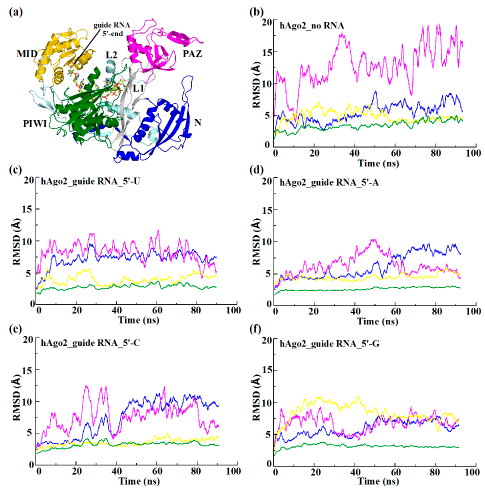
Figure 1. Analysis of backbone RMSD as a function of the simulation time for various hAgo2/guide RNA complexes. RMSD of the individual domains are calculated after superimposition on backbone atoms of the PIWI domain. ( a ) X-ray structure of full-length hAgo2 in complex with a truncated 10-mer guide miRNA (PDB 4F3T). The individual domains are labeled and color-coded: N (blue), PAZ (magenta), MID (gold) and PIWI (green) joined by two linker regions, L1 (silver) and L2 (pale cyan). The protein is represented in cartoon and the guide RNA in licorice; ( b ) Free hAgo2 in the absence of bound guide RNA; and hAgo2–guide RNA complexes with U ( c ); A ( d ); C ( e ); or G ( f ) at the 5 ′ -end of the RNA.